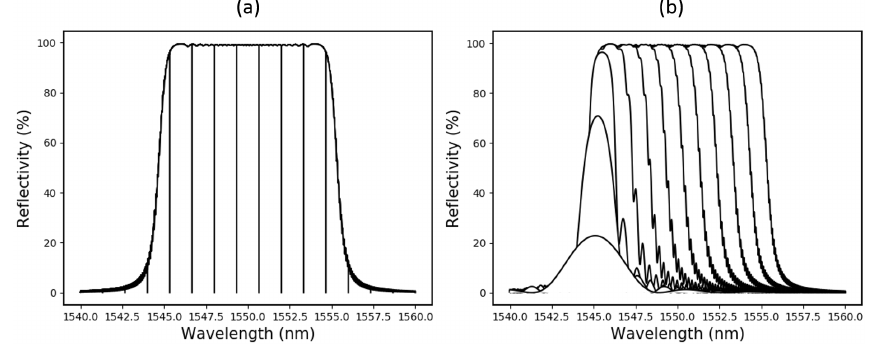
Figure 11. ( a ) How a reflection CFBG spectrum can be integrated, with the bandwidth incrementally removed, to create a crude calibration plot; and ( b ) a more accurate calibration plot, where the spectrum is integrated as the length of a simulated CFBG is